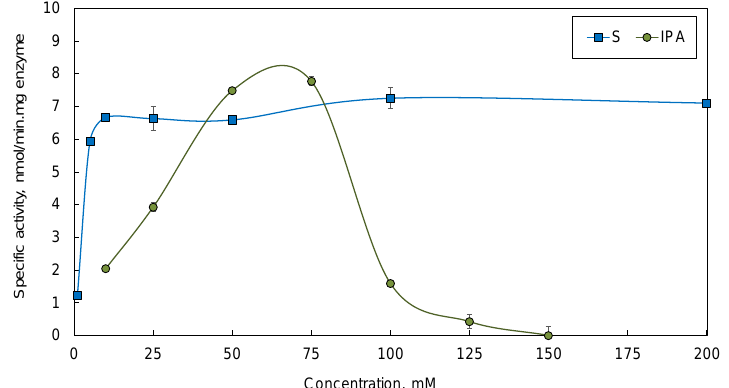
Figure 1. Effect of both isopropylamine (IPA) and 4′-(trifluoromethyl)acetophenone (S) concentrations on TR 8 activity.